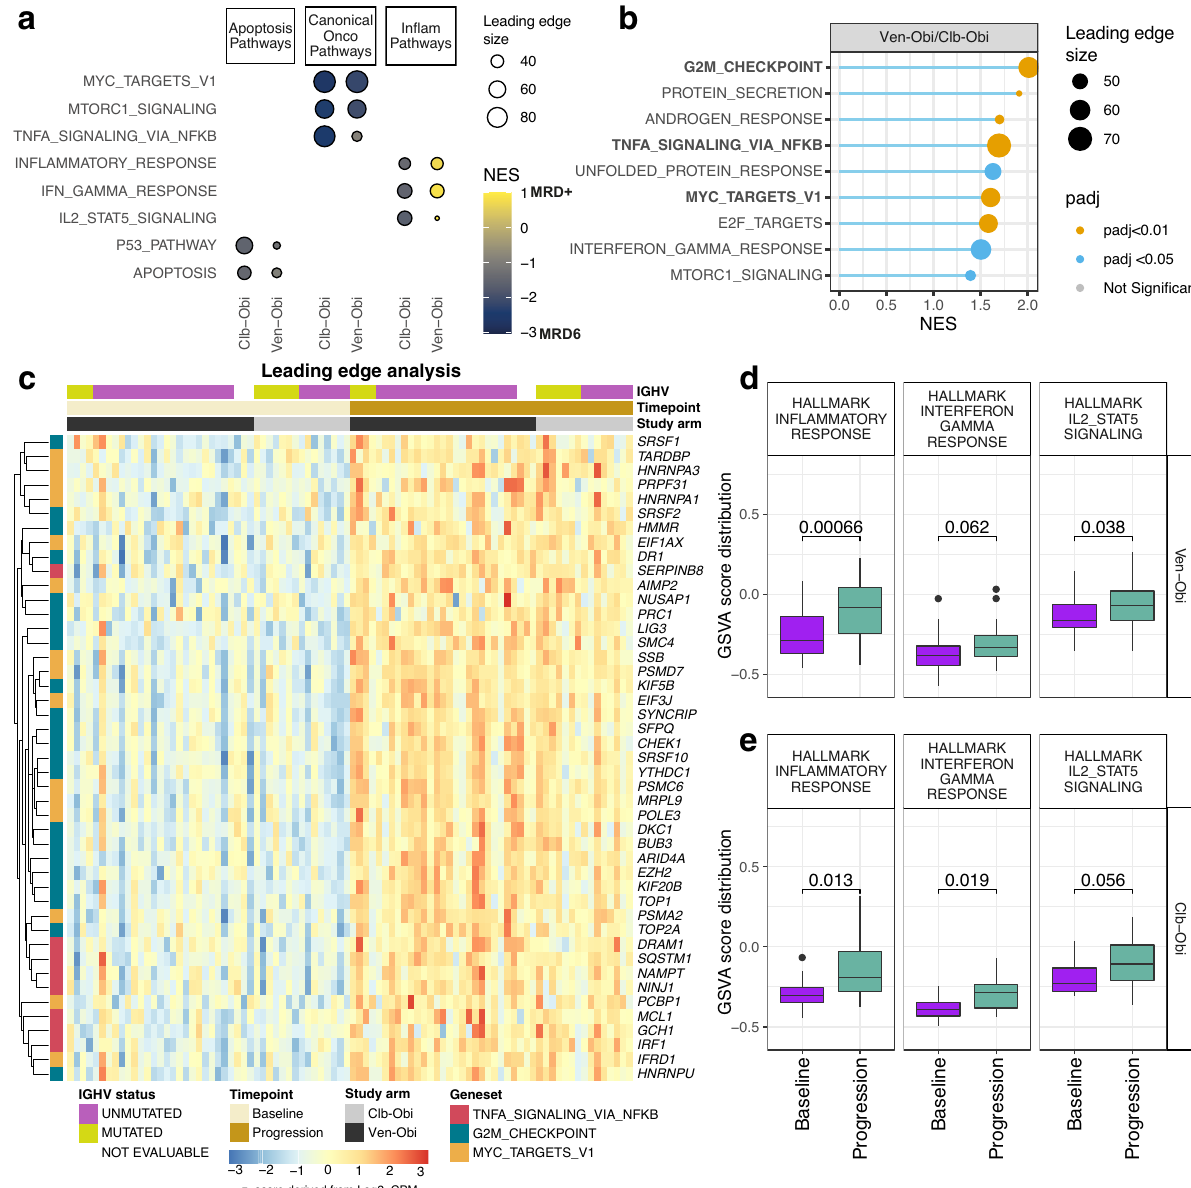
ofbaseline(left)versusrelapse(right)samplesbasedon ‘ TNFasignallingviaNFkB ’ , ‘ G2Mcheckpoint ’ and ‘ MYCtargetsV1 ’ genesets,whichweresigni fi cantlyenriched at relapse. d Gene set variation analysis of selected in fl ammatory pathways before Ven-Obi (D, n =29) or Clb-Obi ( e , n =15) treatment (baseline) and at relapse (pro- gression); two-sided Wilcoxon signed-rank test, not adjusted for multiple testing. boxplotsrepresentlowerquartile,medianandupperquartile,whiskersextendtoa maximum of 1.5 × IQR beyond the box, points indicate outliers. NES, normalized enrichment score; MRD, minimal residual disease, EOT, end of treatment. Source data of differential gene expression analyses are provided as Source Data fi